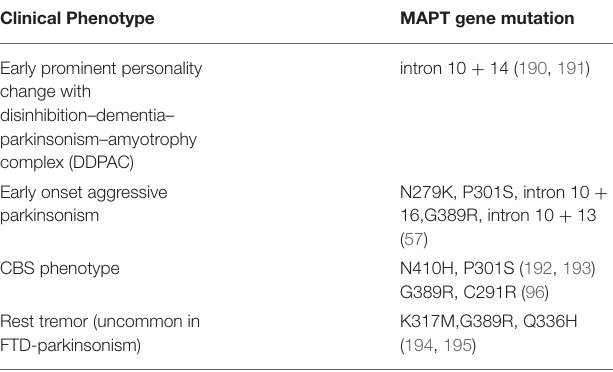
TABLE 6 | Clinical phenotypes associated with MAPT gene mutations. Clinical Phenotype MAPT gene